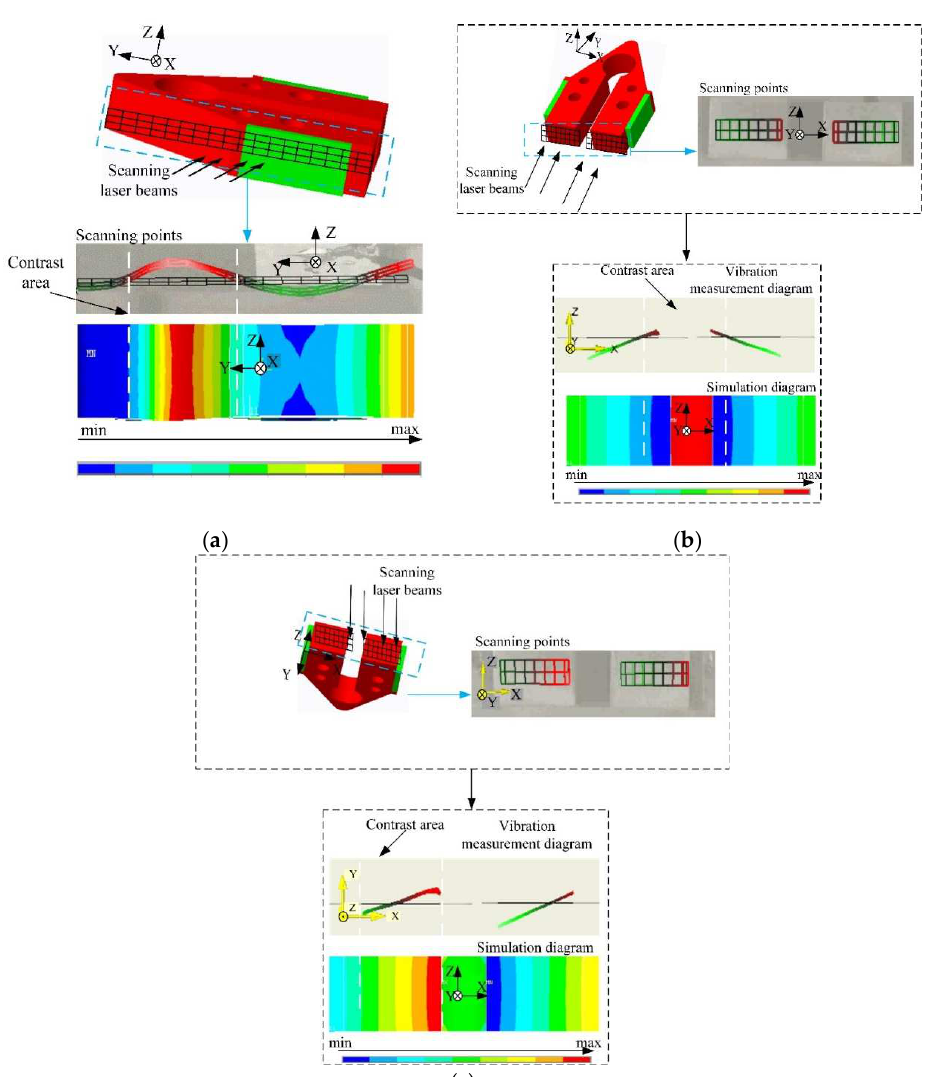
Figure 12. ( a ) Comparison of the test vibration cloud image and simulation mode on the stator side; ( b ) Comparison of vibration cloud image and simulation mode of the symmetrical mode test on the underside of the stator; ( c ) Comparison of vibration cloud image and simulation mode of an antisymmetric modal test on the underside of the stator.